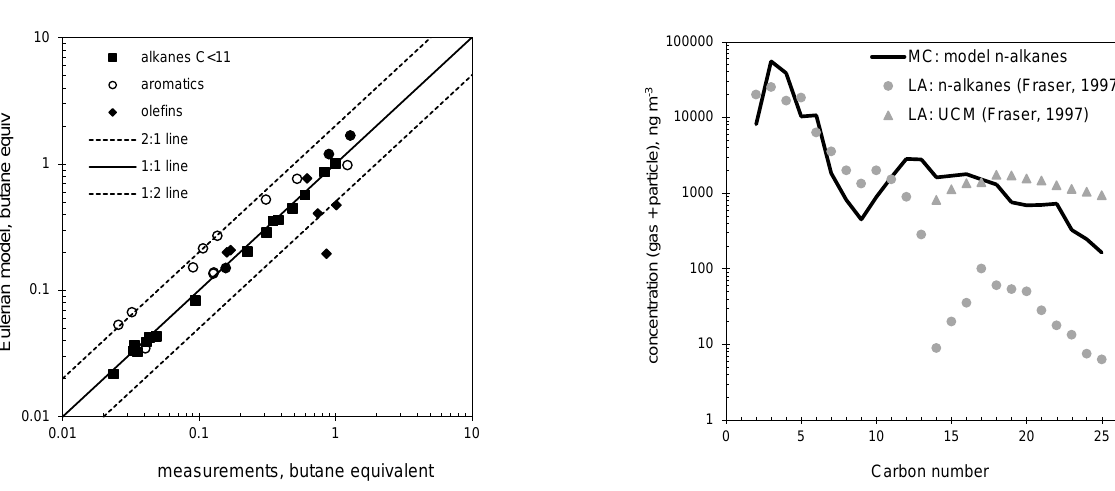
Fig. 5. Diurnal mean concentrations of alkanes in combined gas and aerosol phases. Simulated values are for Mexico City (MC) center. Observations are diurnal means at 4 urban Los Angeles (LA) sites (Fraser et al., 1997). UCM is an observed “unresolved complex mixture” of branched and cyclic